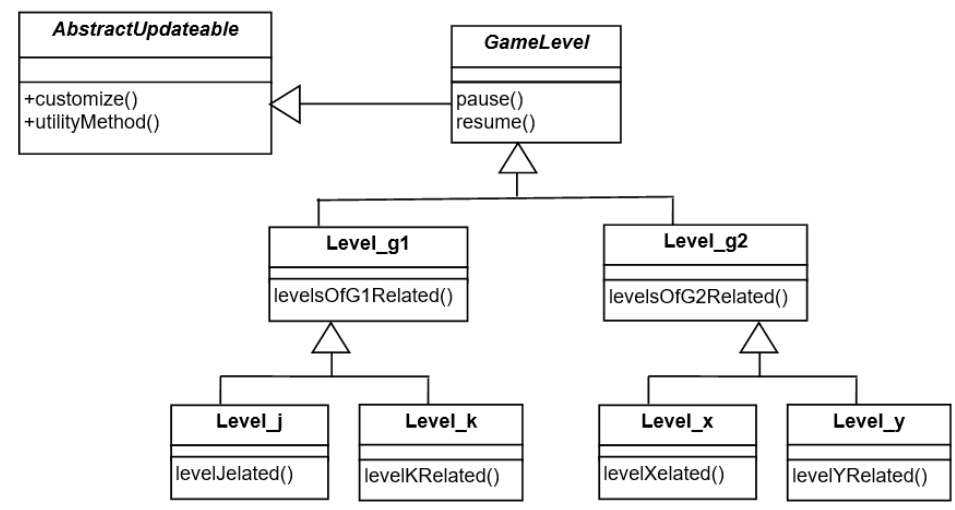
Figure 14. Second alternative approach for implementing Related Levels pattern.